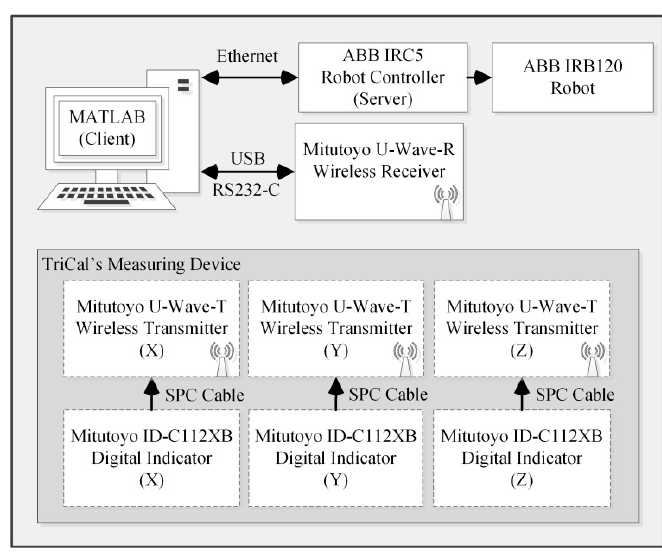
Figure 3. Communication setup.